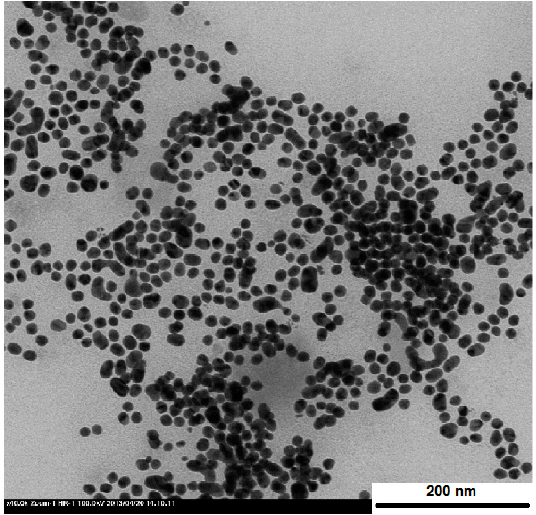
Figure 5. TEM image of AuNPs protected using PVP 40 kDa.